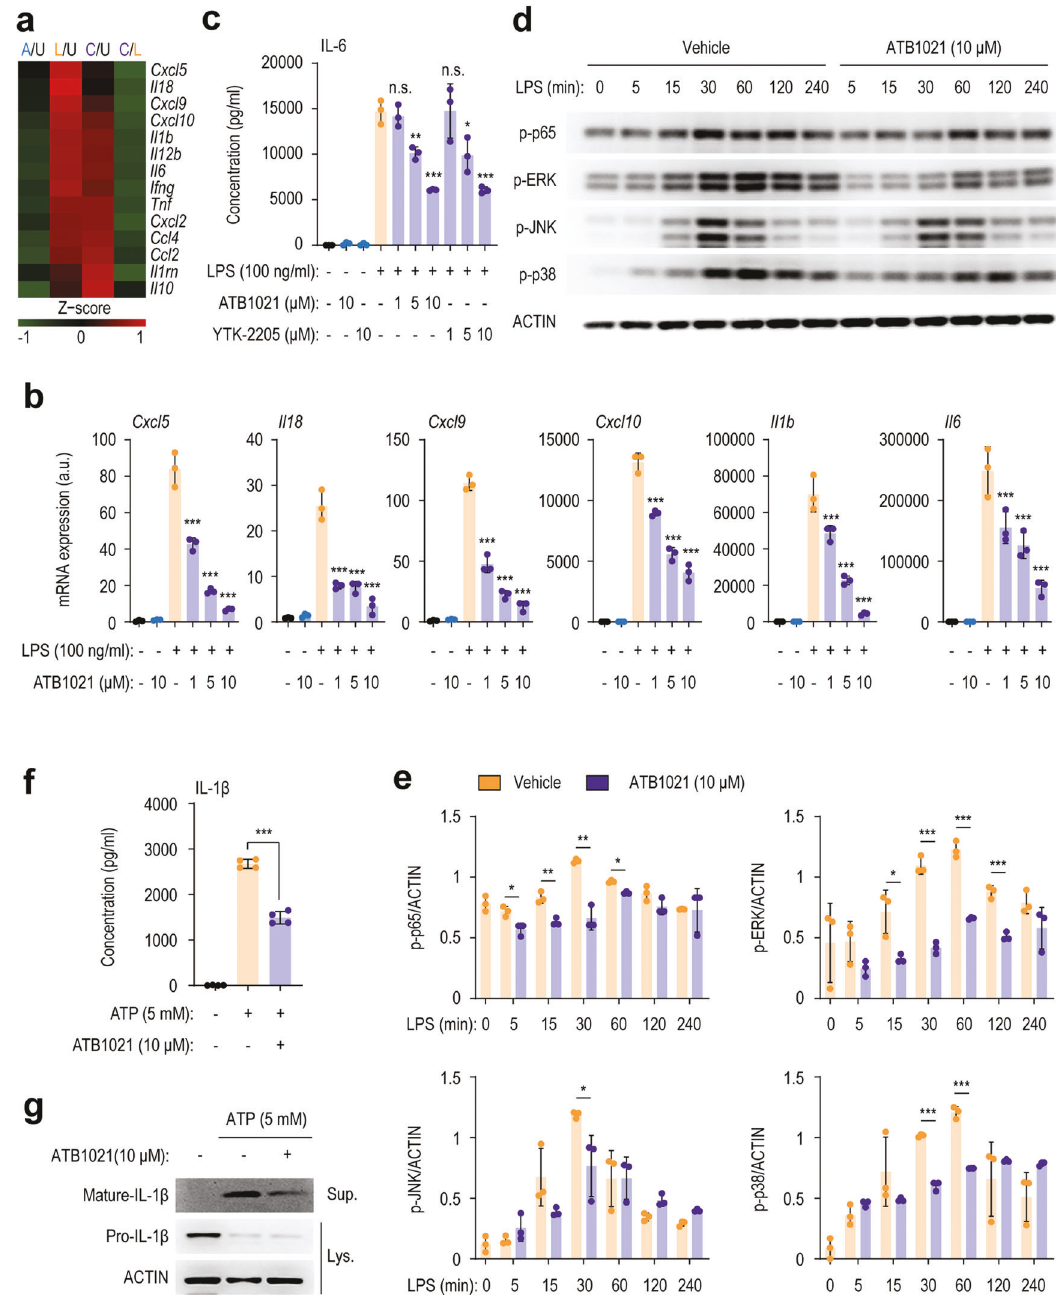
Fig. 2 p62 ligands inhibit LPS-induced proin fl ammatory cytokine production and in fl ammasome activation. a Heatmap of differentially expressed genes in LPS-stimulated macrophages in the presence or absence of ATB1021 (10 μ M). Z scores were calculated using the mean values of biological replicates. A/U, ATB1021 relative to unstimulated; L/U, LPS relative to unstimulated; C/U, ATB1021 plus LPS relative to unstimulated; C/L, ATB1021 plus LPS relative to the LPS stimulated group. b mRNA levels of Cxcl5 , Il18 , Cxcl9, Cxcl10 , Il1b , and Il6 in PMs pretreated with ATB1021 (1, 5, or 10 μ M) for 1 h and stimulated with LPS (100 ng/mL) for 6 h ( n = 3). c ELISA of supernatant collected 18 h after LPS (100 ng/mL) stimulation of PMs treated with ATB1021 or YTK-2205 (1, 5, or 10 μ M) ( n = 3). d , e PMs pretreated with ATB1021 (10 μ M) were stimulated with LPS (100 ng/mL) for the indicated times to assess the phosphorylation of NF- κ B and the MAPKs ERK, JNK, and p38. e Densitometry analysis of the indicated proteins ( n = 3). f , g IL-1 β levels in the culture supernatants of PMs primed with LPS (100 ng/mL) and stimulated with ATP (5 mM) in the presence or absence of ATB1021 (10 μ M) (as determined by ELISA; f , n = 4) or in the supernatant and cell lysate (as determined by Western blotting; g ) for mature or precursor IL-1 β . Means ± SD are shown ( b , c , e , f ). One-way ANOVA with Tukey ’ s multiple comparison test ( b , c ) or two-tailed Student ’ s t test ( c , f ) was used to determine statistical signi fi cance. * p < 0.05, ** p < 0.01, *** p <